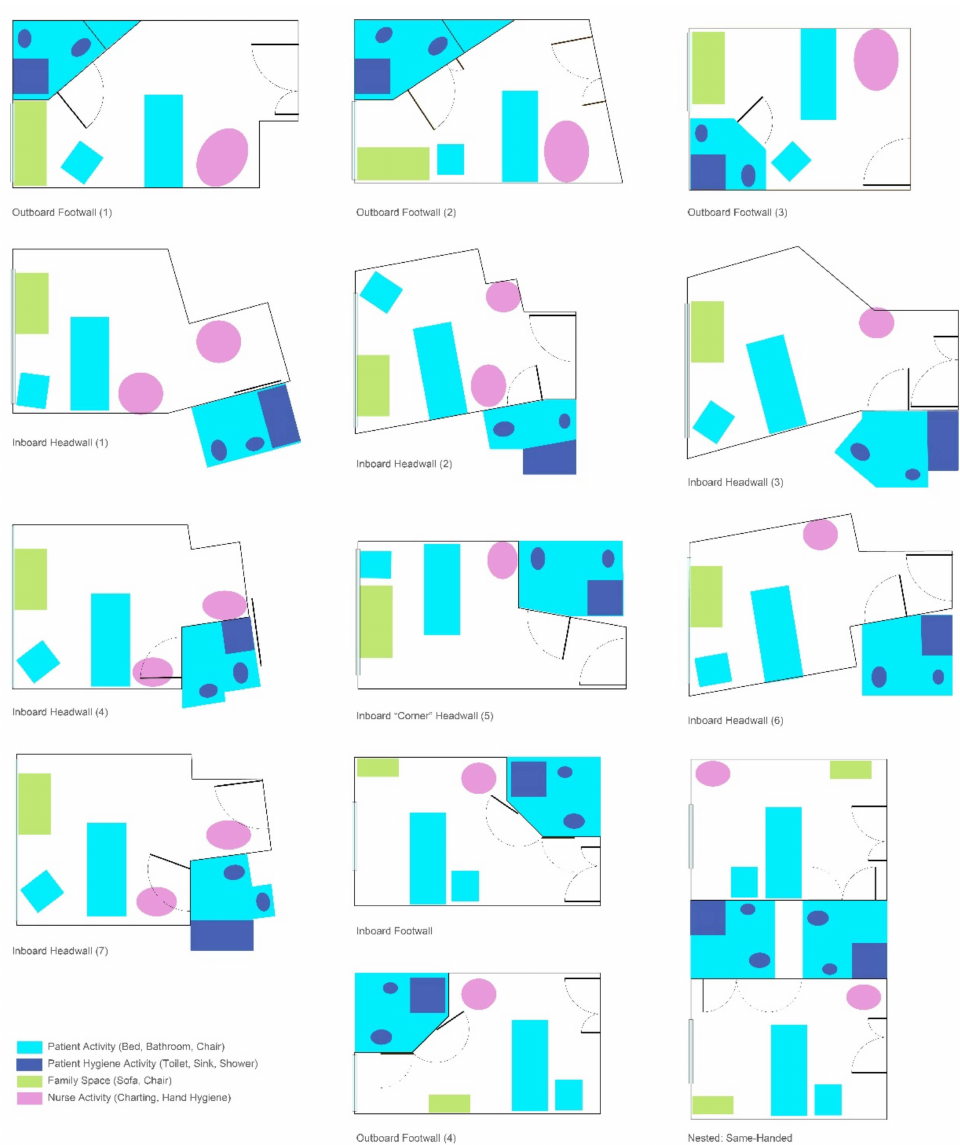
Figure 1. Room configurations submitted by the